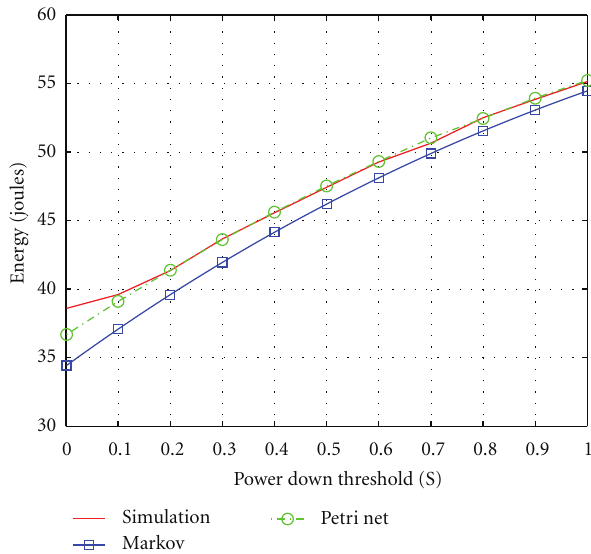
Figure 7: P ow e r Up De lay = 10 seconds.